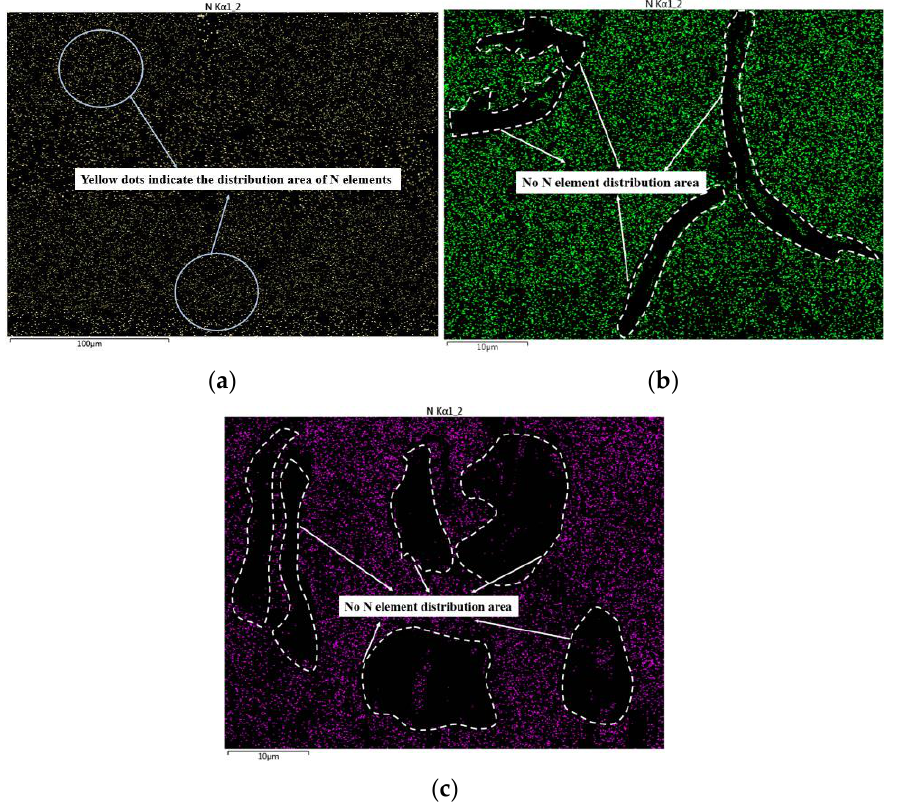
Figure 6. Surface N element distribution of the sample after cleaning ( a – c are the surface N element distribution of samples 1, 2, and 3, respectively).